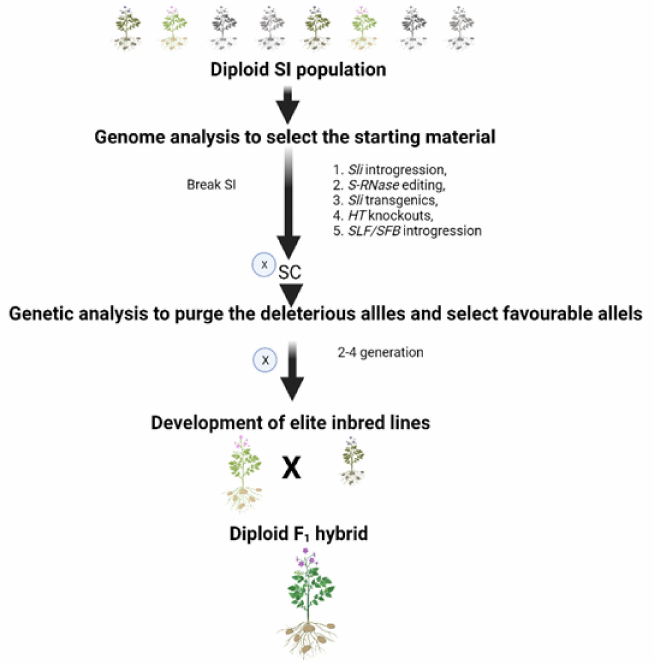
Figure 3. Genomic-assisted breeding approach for the development of a diploid F 1 hybrid. Based on genome analysis, the starting material can be selected from the pool of diploid germplasm. The SI barrier of selected material can be overcome by five possible approaches: 1. S-locus inhibitor ( Sli ) is introgressed from a self-compatible Sli donor in which it naturally occurs; 2. Editing of S-RNase; 3. Sli gene transformation; 4. HT knockouts; or 5. SLF/SFB introgression. Elite inbred lines can be developed by selfing up to 2–4 generations after purging the deleterious alleles. The vigorous F 1 hybrids can be developed by crossing the elite inbred lines from the different